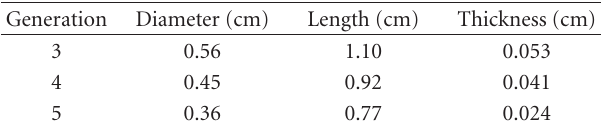
Table 1: Parameters for airway generations 3 to 5 based on ICRP [22] tracheobronchial geometry, and measurements by Habib et al. [23].